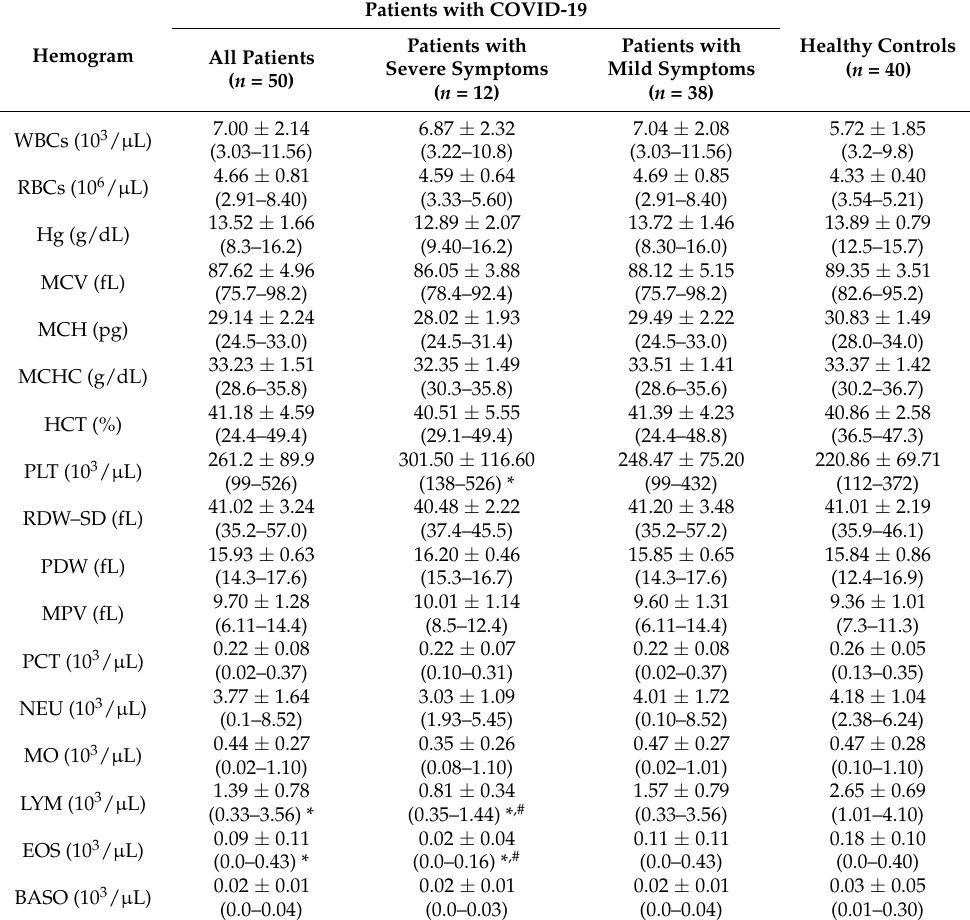
Table 2. Hemograms of the study groups.